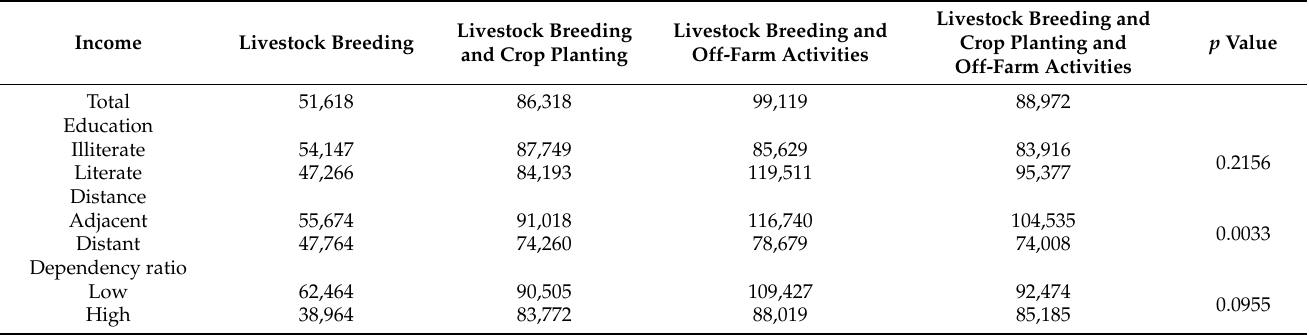
Table 3. Income of households adopting different livelihood strategies